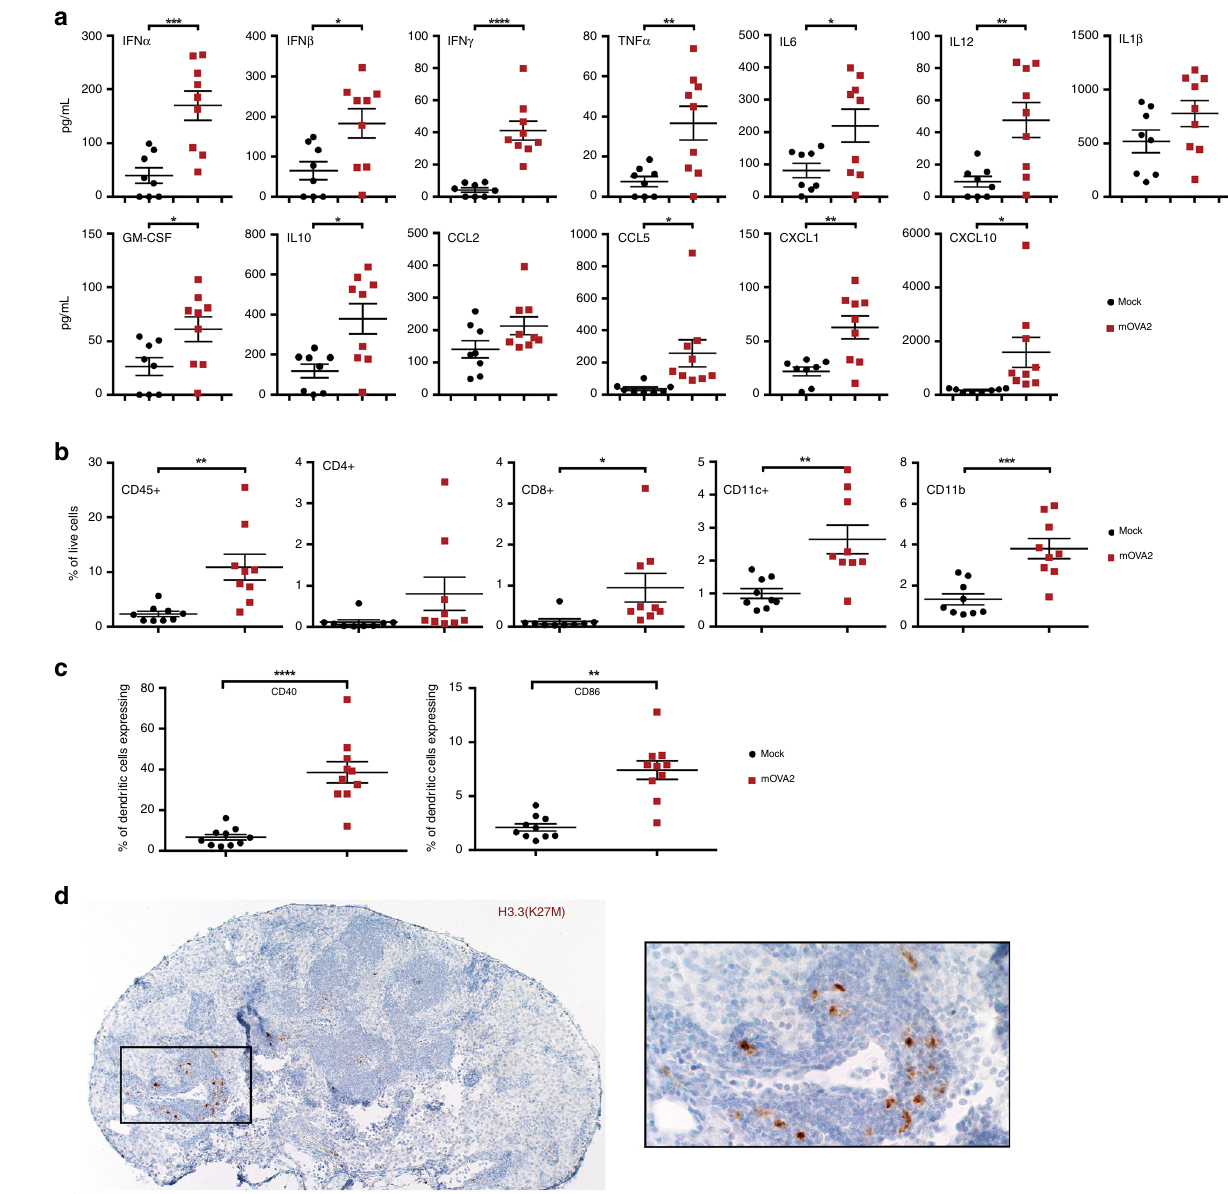
Fig. 4 Intramuscular immunization with PVSRIPO vectors induced locoregional in fl ammation. a Cytokine induction pro fi le in gastrocnemius muscle 12 h post i.m. immunization with mOVA2 ( n = 9) or DMEM (Mock; n = 8). b Immune in fi ltrates in treated muscle 24 h post immunization with mOVA2 ( n = 9) or DMEM (Mock; n = 9). c Upregulation of costimulatory molecules on muscle-in fi ltrating DCs upon immunization mOVA2 ( n = 10) or DMEM (Mock; n = 10). b , c Representative gating is shown in Supplementary Figs. 8, 9. d Immunohistochemistry of the H3.3 K27M epitope in a popliteal lymph node draining the mRIPO(H3.3) inoculation site. H3.3 K27M positive cells, presumably antigen-presenting cells infected with mRIPO(H3.3), are observed. H3.3 K27M staining in sections from lymph nodes of a mock-immunized animal, and isotype-matched negative control staining of sections from the